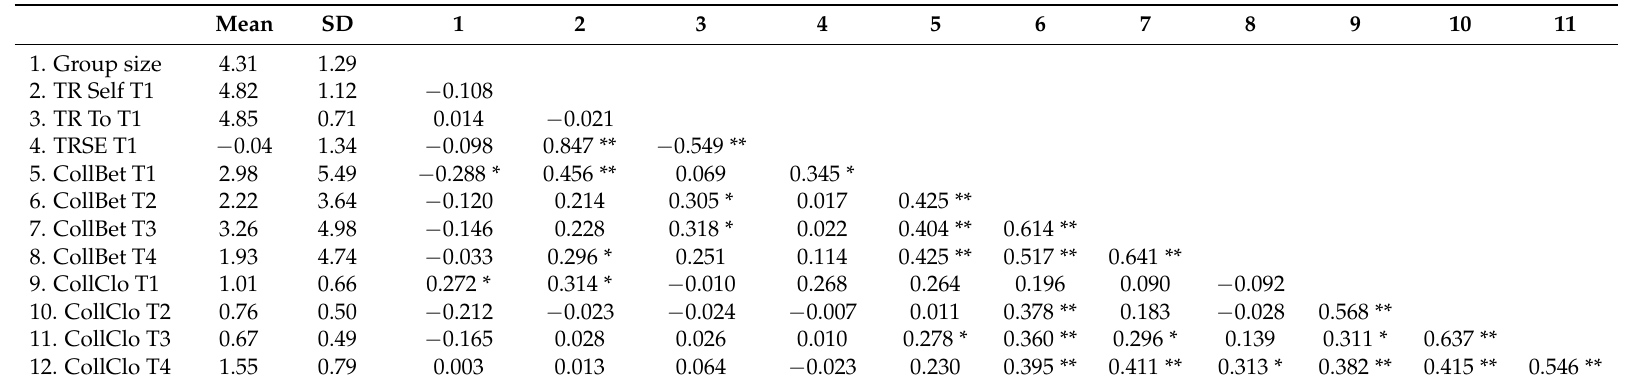
Table 1. Means, standard deviations, and correlations for the variables included in the